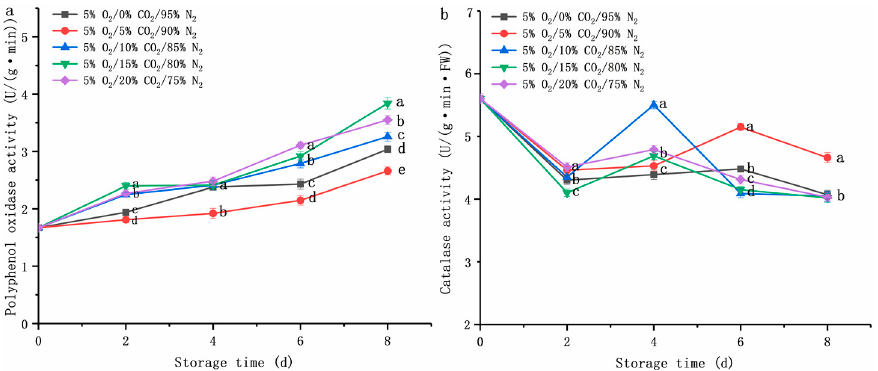
Figure 4. Effect of CO 2 concentration (%) with 5% O 2 on polyphenol oxidase activity ( a ), and catalase activity ( b ) of fresh-cut Dictyophora rubrovolvata . Differences at p < 0.05 are indicated by different letters and data are expressed as the mean ± SD.